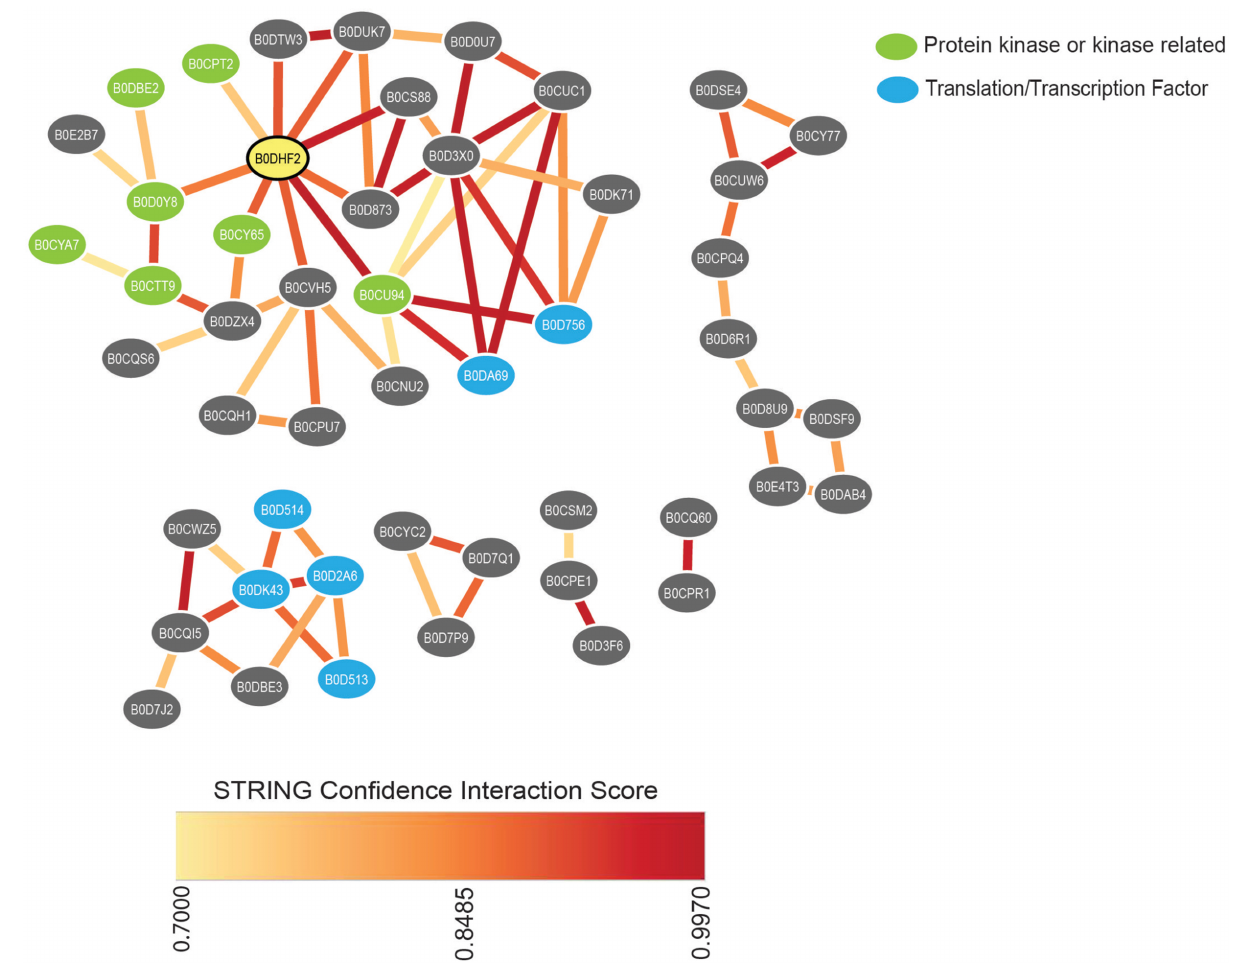
FIGURE 4 | STRING network of all common downregulated proteins in treatments compared to control samples belonging to “cellular component assembly” and “establishment of cell polarity” GO categories. The network summarizes the predicted associations between proteins found by the STRING database. Each protein is represented by a node and the edges represent predicted functional associations. Edge colors indicate the confidence interaction score based on different types of evidence considered by STRING. Only protein-protein associations with high confidence scores ( ≥ 0.7) were considered in the predicted network. The node representing the CMGC/CDK/CDC2 protein kinase is highlighted in yellow. Disconnected proteins in the network are not